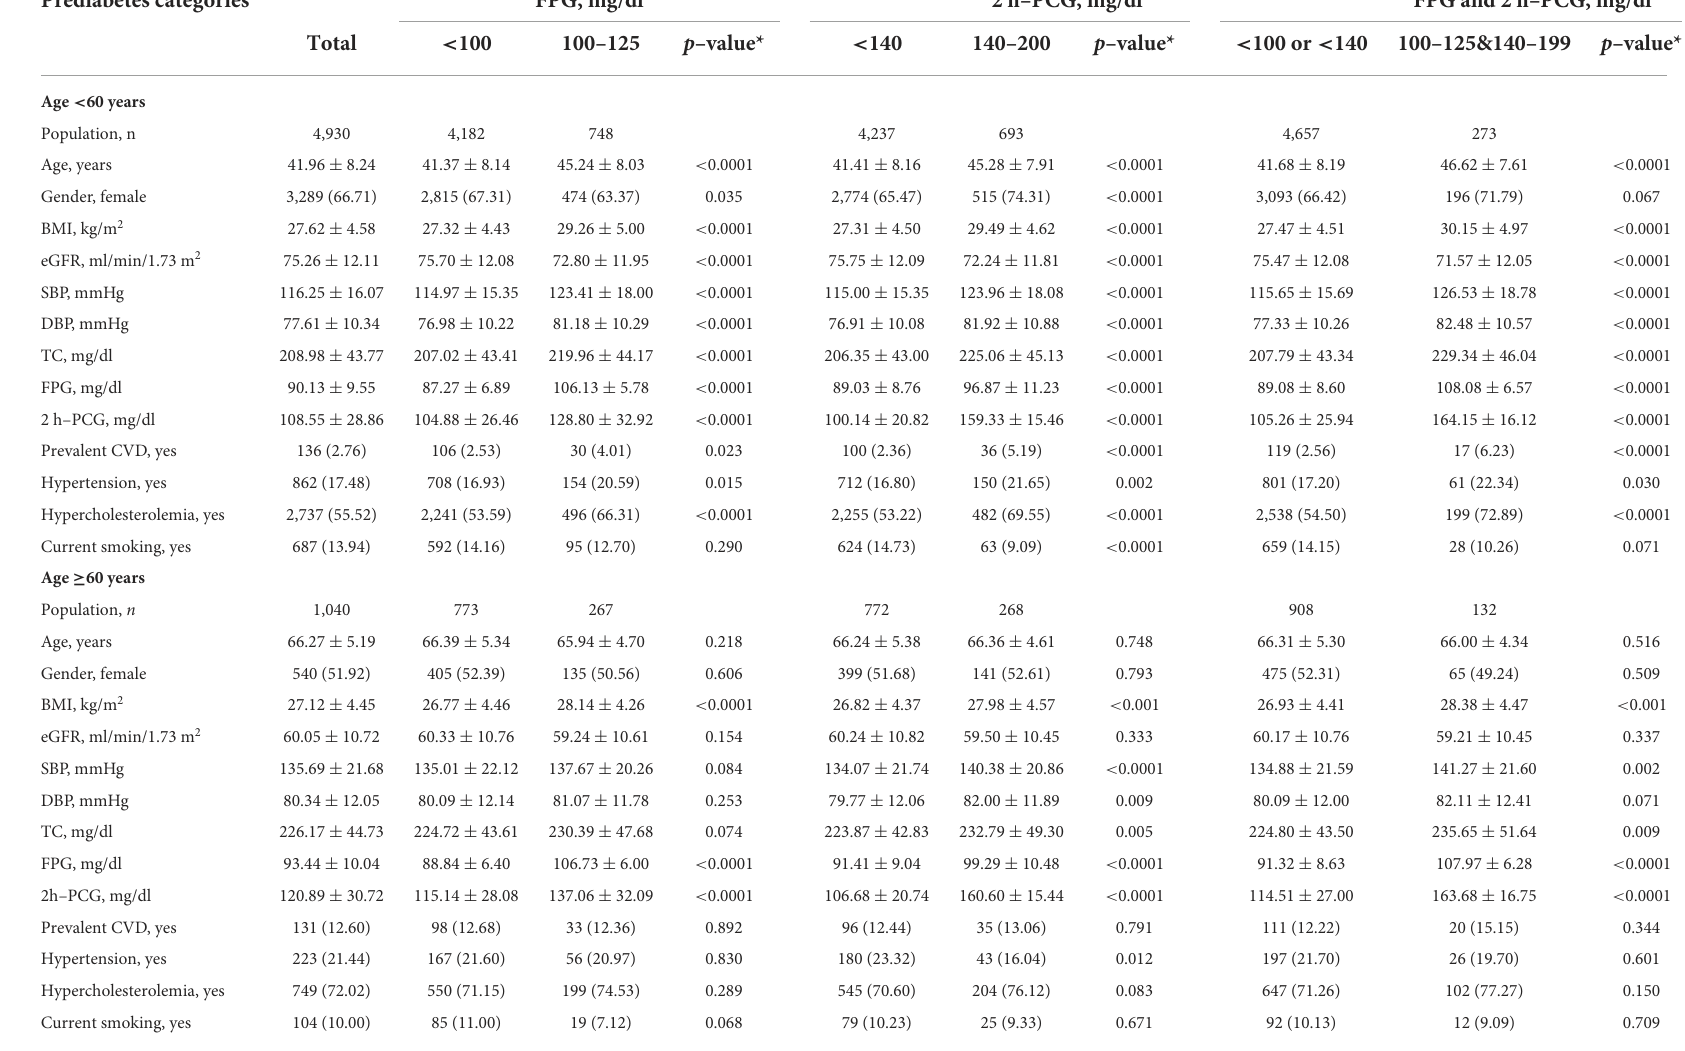
TABLE 1 Baseline characteristics of the study participants ( N = 5,970) according to the prediabetes categories: Tehran lipid and glucose study